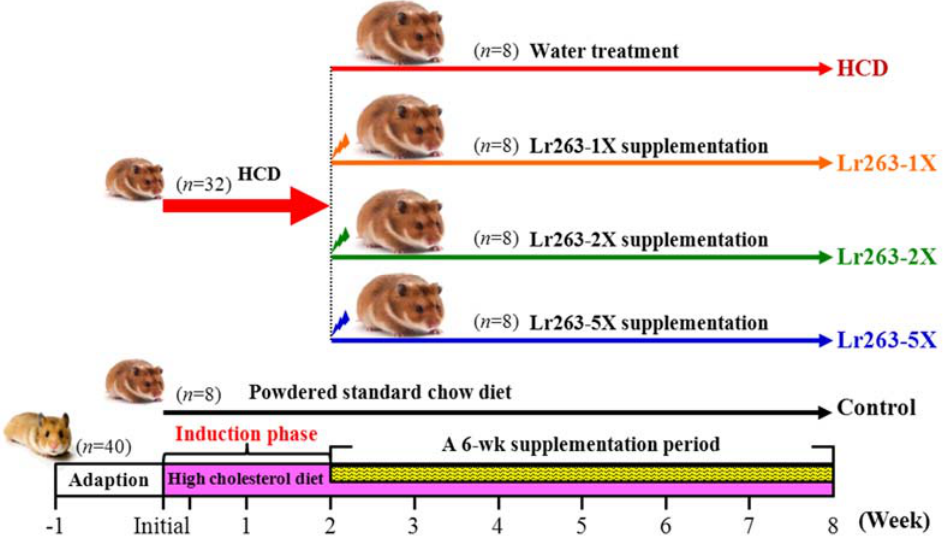
Figure 1. Experimental design. Control: Healthy hamsters were fed a standard laboratory diet and orally received the same volume of solution equivalent to body weight